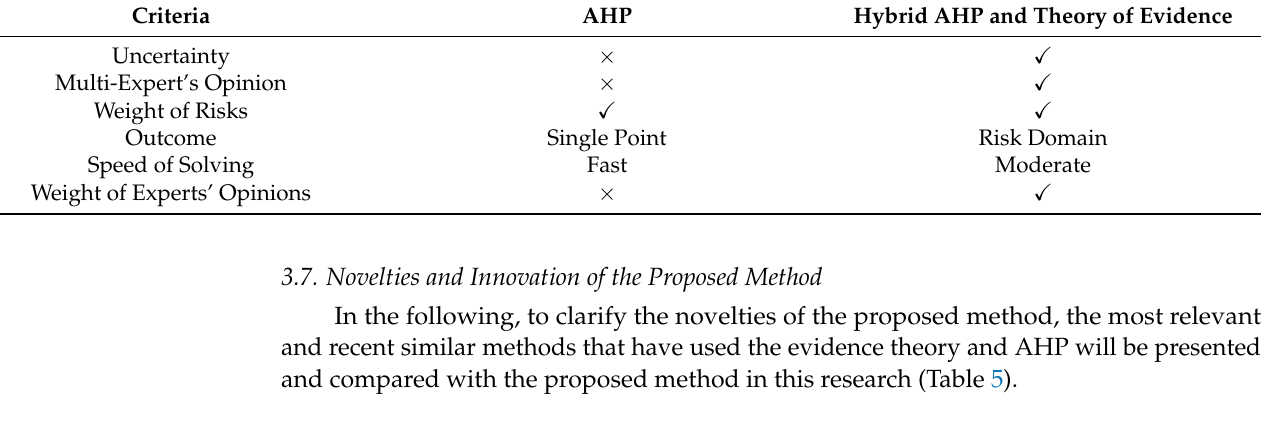
Table 5. The results of comparing the proposed method with similar methods in the literature. The